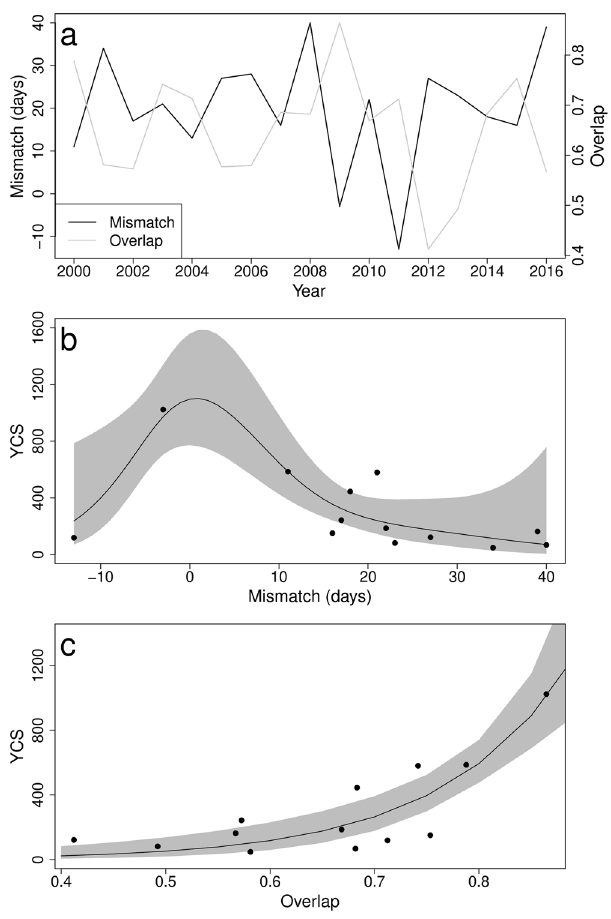
Figure 3. Variations in the mismatch and overlap measures. ( a ) Inter-annual variations and relationships between sandeel recruitment index (YCS) and ( b ) the mismatch measure and ( c ) the overlap measure. 95% CIs are indicated by the grey area around the mean prediction (solid